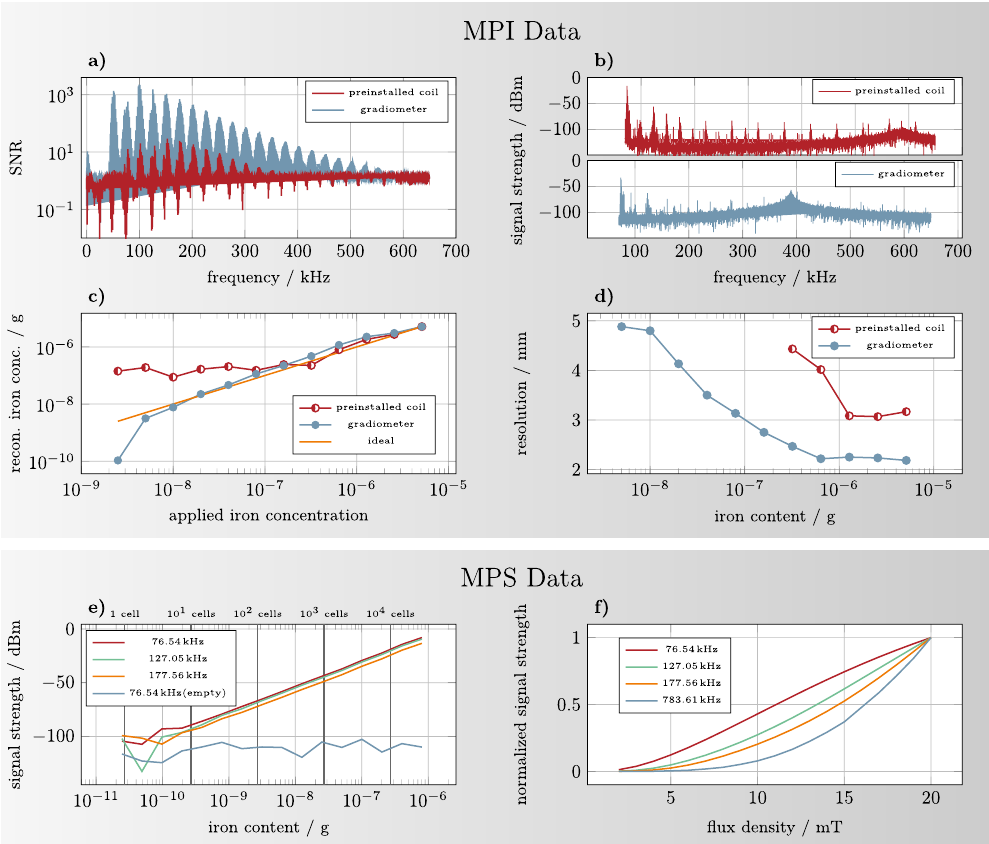
Figure 4. ( a ) SNR of the system matrix used in the in vitro experiments for both receive coils as a function of frequency. ( b ) Empty measurements of the installed receive coil and the gradiometer. The plotted MPI signal is given in dBm calculated in relation to a 50 Ω impedance. Due to the different values of input capacitance of the LNA and inductance of receive coil the resonance peak is shifted compared to the preinstalled coil. ( c ) Calculated iron content determined by integration of the reconstructed particle distribution shown in Fig. 6 plotted against the applied iron content. ( d ) Full-width at half maximum of the reconstructed dot in z direction (vertical) as a function of the concentration for both receive coils. Shown are only those concentrations where a dot could be clearly detected. ( e ) Sensitivity of the MPS device 38 . The system shows a linear scaling of the harmonics down to a total iron content of 192 pg for LS-008 particles. For orientation, the number of cells for an iron load of 27 pg per cell which has been reported by Zheng et al . 14 is drawn. ( f ) Scaling of the signal intensity over drive field strength for 10 μ L undiluted LS-008 particles. All harmonics show a nonlinear behavior for low drive field strengths converging to a linear scaling for higher field